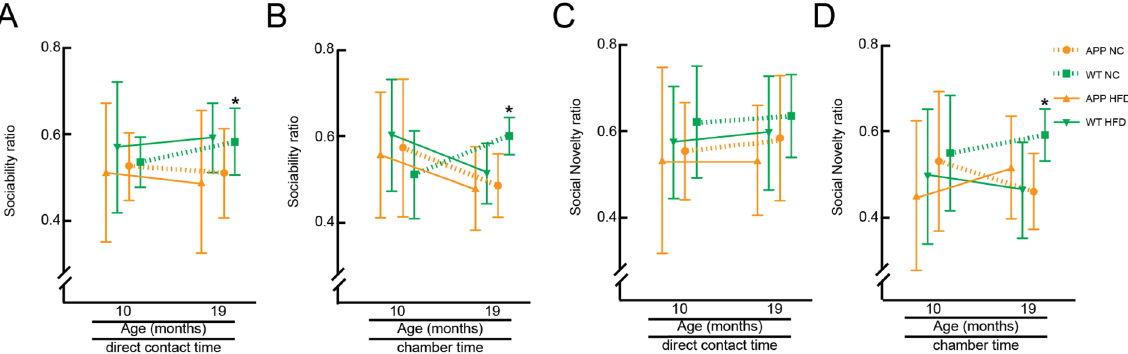
Figure 4. Behavioral assays for social interaction and novelty in APP/PS1 and WT mice on a Hfd or normal chow at 10 and 19 months of age. Groupwise averages for the 3-chamber sociability score, measured as direct interaction time with the stranger vs. an empty chamber ( A ) and time spent in chamber with the stranger vs. the empty chamber ( B ), at 10 and 19 months of age. Groupwise averages for the 3-chamber social novelty score, measured as direct interaction time with the novel stranger vs. the old stranger ( C ) and time spent in chamber with the novel stranger vs. the chamber with the old stranger ( D ), at 10 and 19 months of age. Animal numbers for all measurements — 10 months: APP/PS1-NC: n = 9; WT-NC: n = 11; APP/PS1-Hfd: n = 13; WT-Hfd: n = 13; 19 months: APP/PS1-NC: n = 5; WT-NC: n = 8; APP/PS1-Hfd: n = 10; WT-Hfd: n = 11; * p < 0.05 between genotypes (APP/PS1 vs. WT); one-way ANOVA with Holm-Šídák multiple comparisons correction.